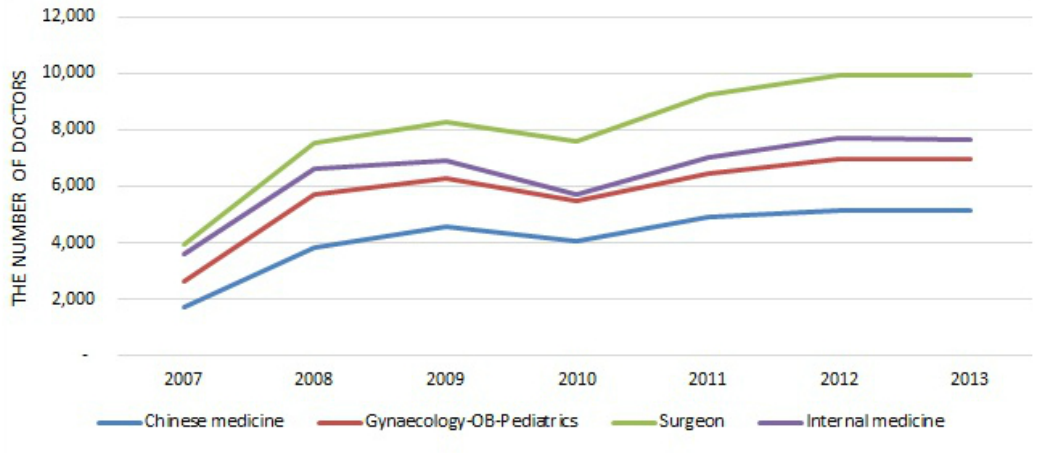
Figure 8. Number of doctors rated over time among four major specialty